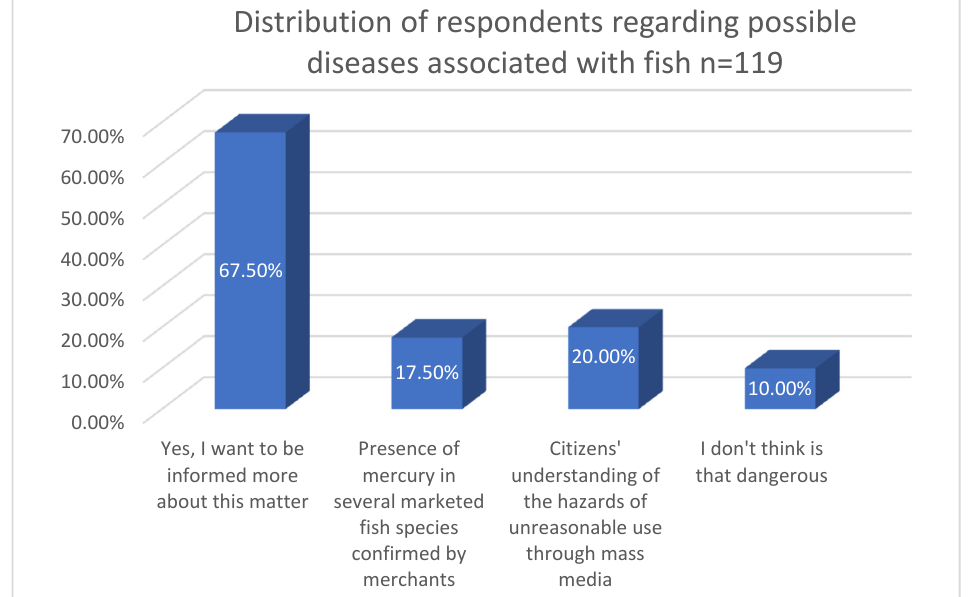
Figure 9. Distribution of respondents regarding suggestions on improving access to information on the toxicity of fish products.